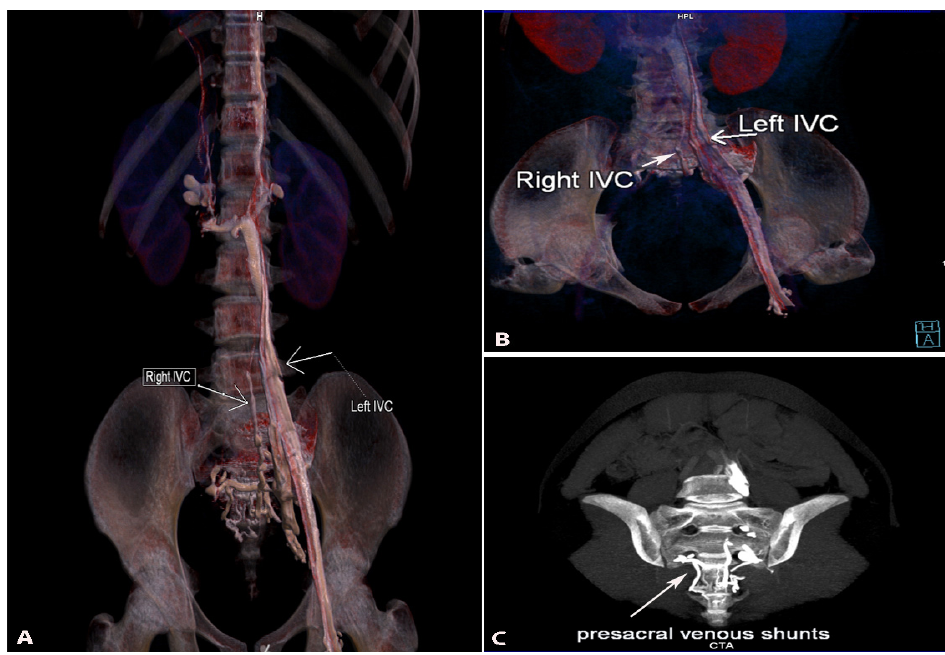
Figure 18. Double inferior vena cava with regressed right inferior vena cava. ( A )—3D volume rendered reconstruction in coronal view. Right-sided IVC is regressed with multiple presacral venous communications between both caval systems. ( B )—3D volume rendered reconstruction in coronal oblique view. Left dominant inferior vena cava is annotated with an arrow. The right regressed inferior vena cava is the vessel just in front of the spine. ( C )—maximum intensity projection—oblique view parallel to coronal sacral plane. Multiple venous shunts are seen occupying the presacral region. The right-sided DIVC is defined as a presence of two infrarenal right IVCs, which are located at the right side of the AA. Tagliafico et al. described a case of a right-sided